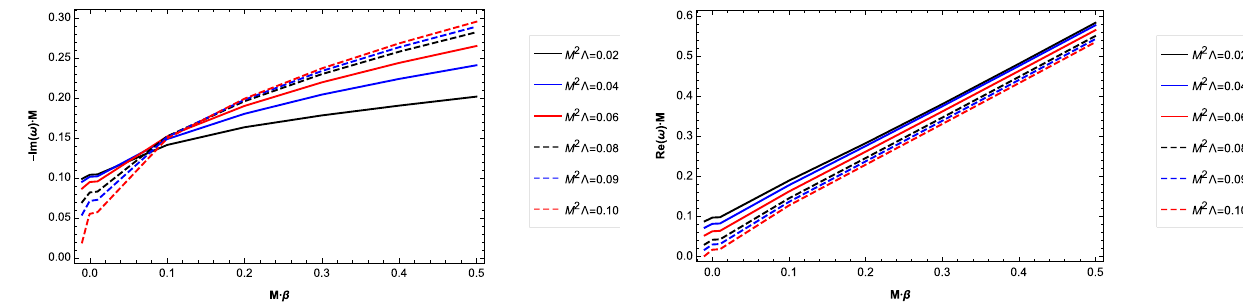
Fig. 2 The behavior of Im (ω) M (left panel) and Re (ω) M (right panel) for the fundamental QNF as a function of M β for massless scalar field with (cid:5) = 0 and different values of the cosmological constant